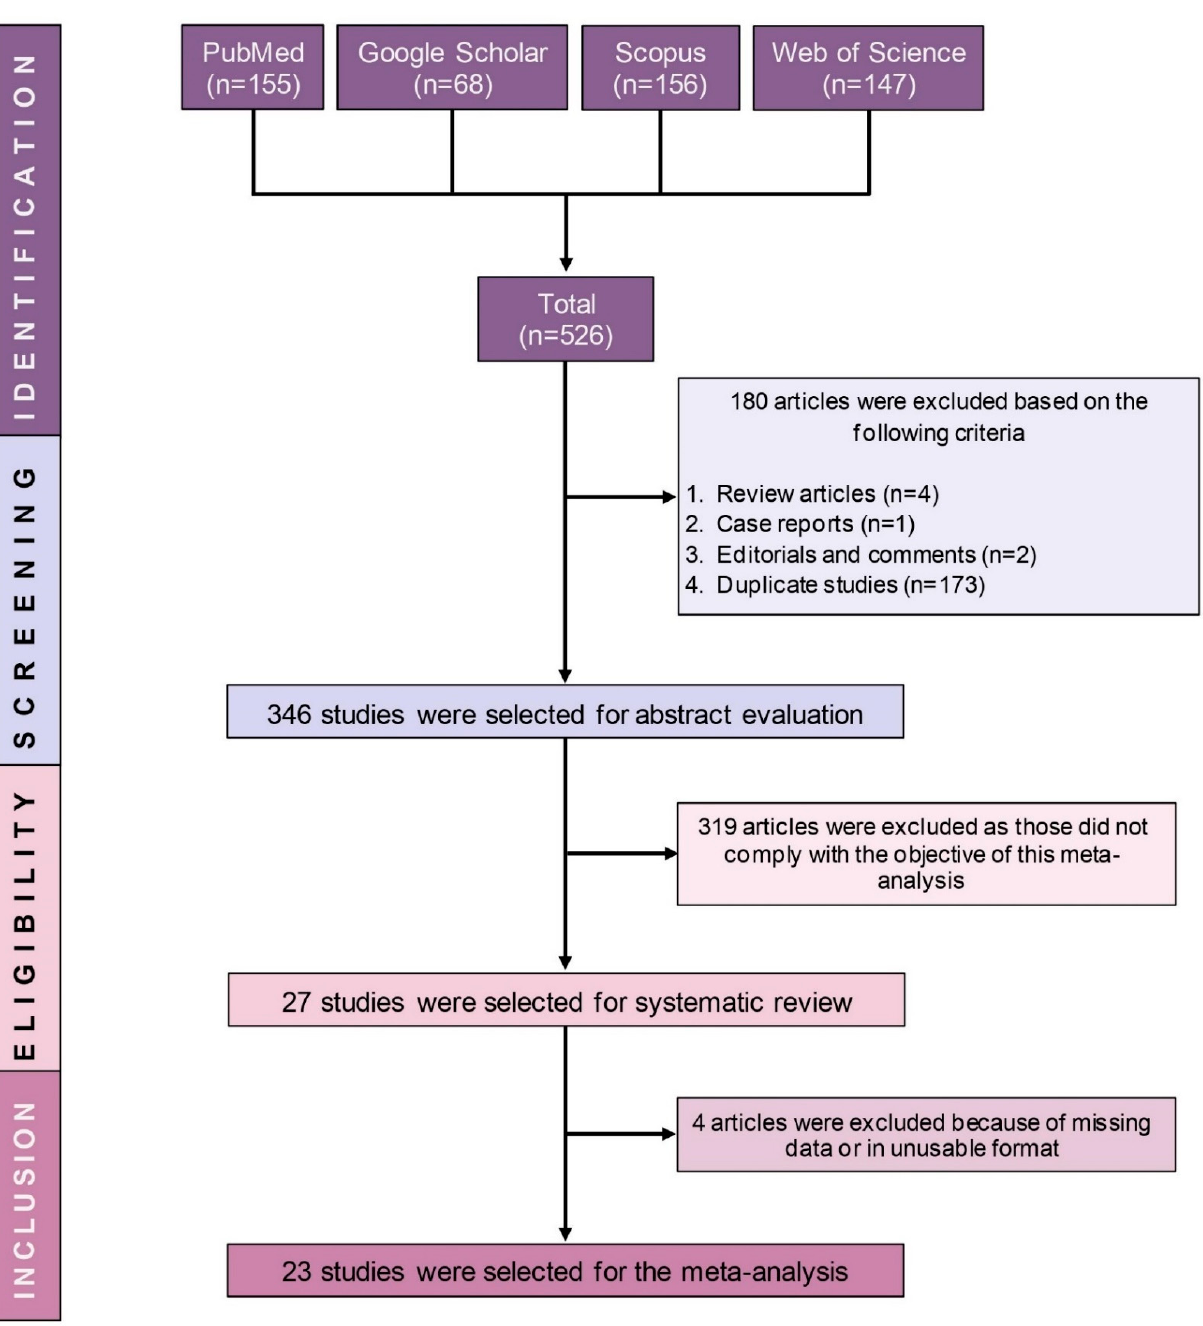
Figure 1. PRISMA flow diagram of study selection.